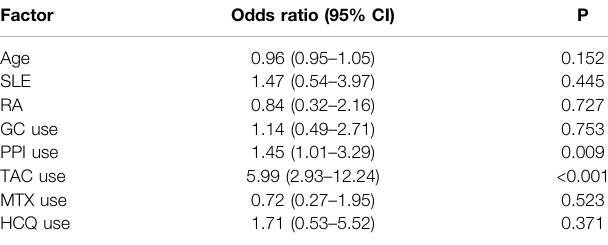
TABLE 2 | Multivariate analysis for factors associated with